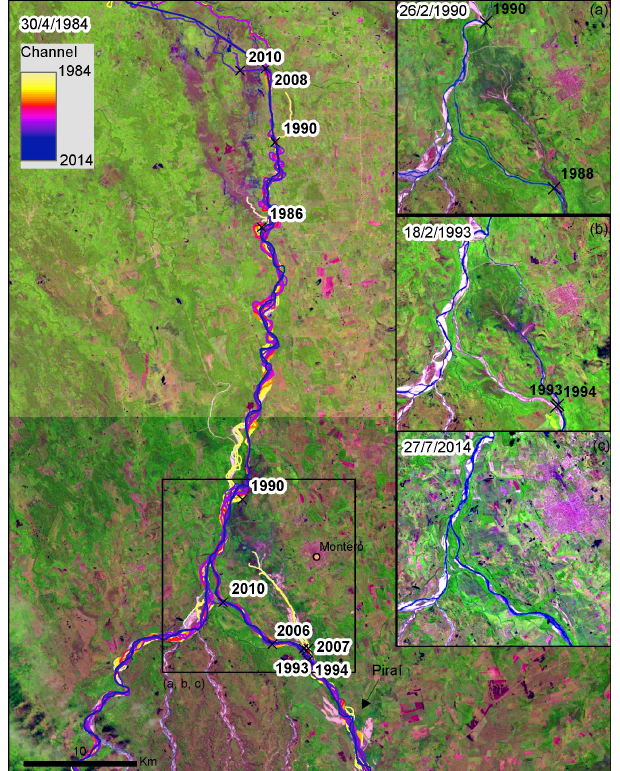
Figure 9. Avulsions of the Río Piraí. There are two regions where crevasse splays and avulsions are taking place, in the proximity of the town of Montero (insets a–c ), and about 30km north. In the more distal zone, the Piraí has formed several different avulsive courses, causing large floods. In the last decade the river channel has been straightened by farmers (upper part of the figure), in an attempt to control the